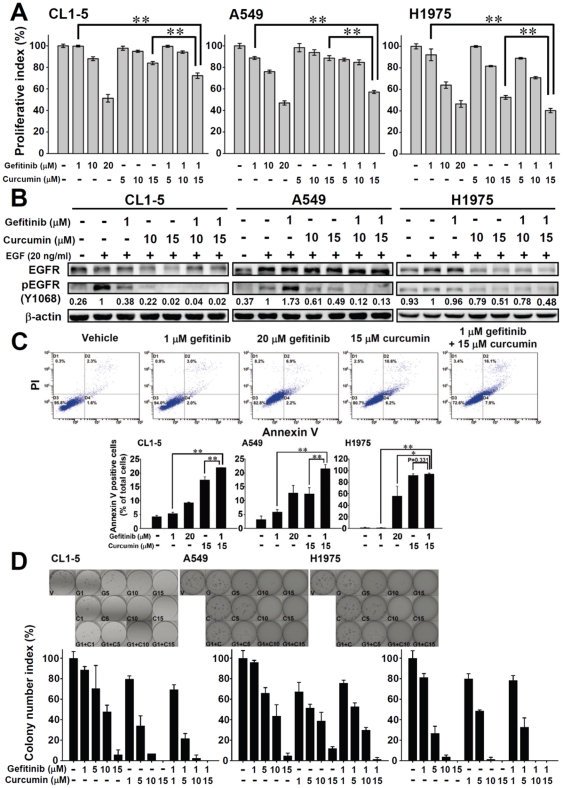
Curcumin potentiates antitumor abilities of gefitinib in cell proliferation, EGFR activation, apoptotic ability, and colony formation of gefitinib in gefitinib-resistant in NSCLC in vitro.(A) MTT assay results showed curcumin enhanced the anti-proliferative effect of gefitinib in CL1-5, A549 and H1975 gefitinib-resistant lung adenocarcinoma cell lines. Columns, mean (n = 6); bars, SEM. **, P<0.01. Data are representative of two independent experiments. (B) Western blotting analysis showed curcumin improve the blockage of EGF (20 ng/ml)-induced EGFR and pEGFR expression of gefitinib in CL1-5, A549 and H1975 cell lines. β-actin used as the internal control and the numbers below the row of the pEGFR indicate the densitometric values normalized with the relative β-actin value. (C) Annexin V-FITC apoptosis assay results showed curcumin enhance the apoptotic effect of gefitinib, CL1-5 cell was treated agents as indicating. The x axis is Annexin-V-FITC, and the y axis is PI (propidium iodide) for all graphs represented; CL1-5, A549 and H1975 cells undergoing apoptosis were statistically counted the Annexin-V+ and PI- levels of total cells in the lower right quadrant. Columns, mean (n = 3); bars, SD. *, P<0.05, **, P<0.01 and P = 0.331 (15 µM curcumin versus 1 µM gefitinib plus 15 µM curcumin). Data are representative of triplicate independent experiments. (D) Colony formation assay analysis represented curcumin enhance the colony inhibitory ability of gefitinib in CL1-5, A549 and H1975 cells. Cells cell was treated agents as indicating; V: vehicle control, G1, G5, G10, G15, C1, C5, C10, C15, G1+C1, G1+C5, G1+C10 and G1+C15: G and C indicated gefitinib and curcumin, and number showed the concentrations (µM) of the agents, respectively; Colony formation index (%) was expressed as the percent of cells number in the each groups compared to the vehicle control. Colonies were counted after 2 weeks of the experiment using crystal violet staining. Columns, mean (n = 3); bars, SD. Data are representative of two independent experiments.